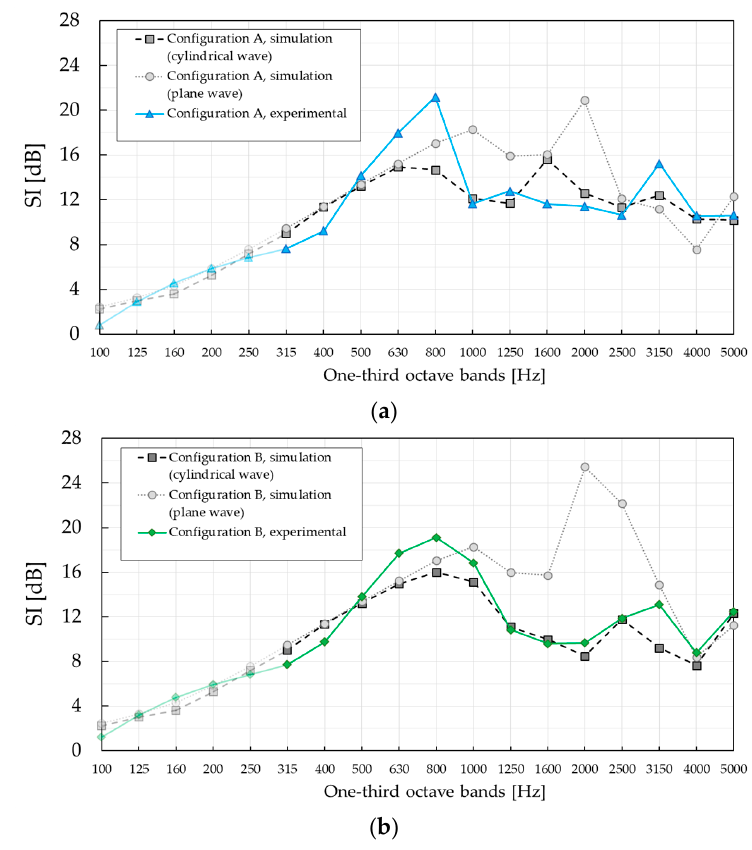
Figure 13. Comparison of SI experimental and finite element (FE) simulations results averaged over three microphone positions—M4, M5, and M6. ( a ) Sound insulation index SI , configuration A . ( b ) Sound insulation index SI , configuration B .